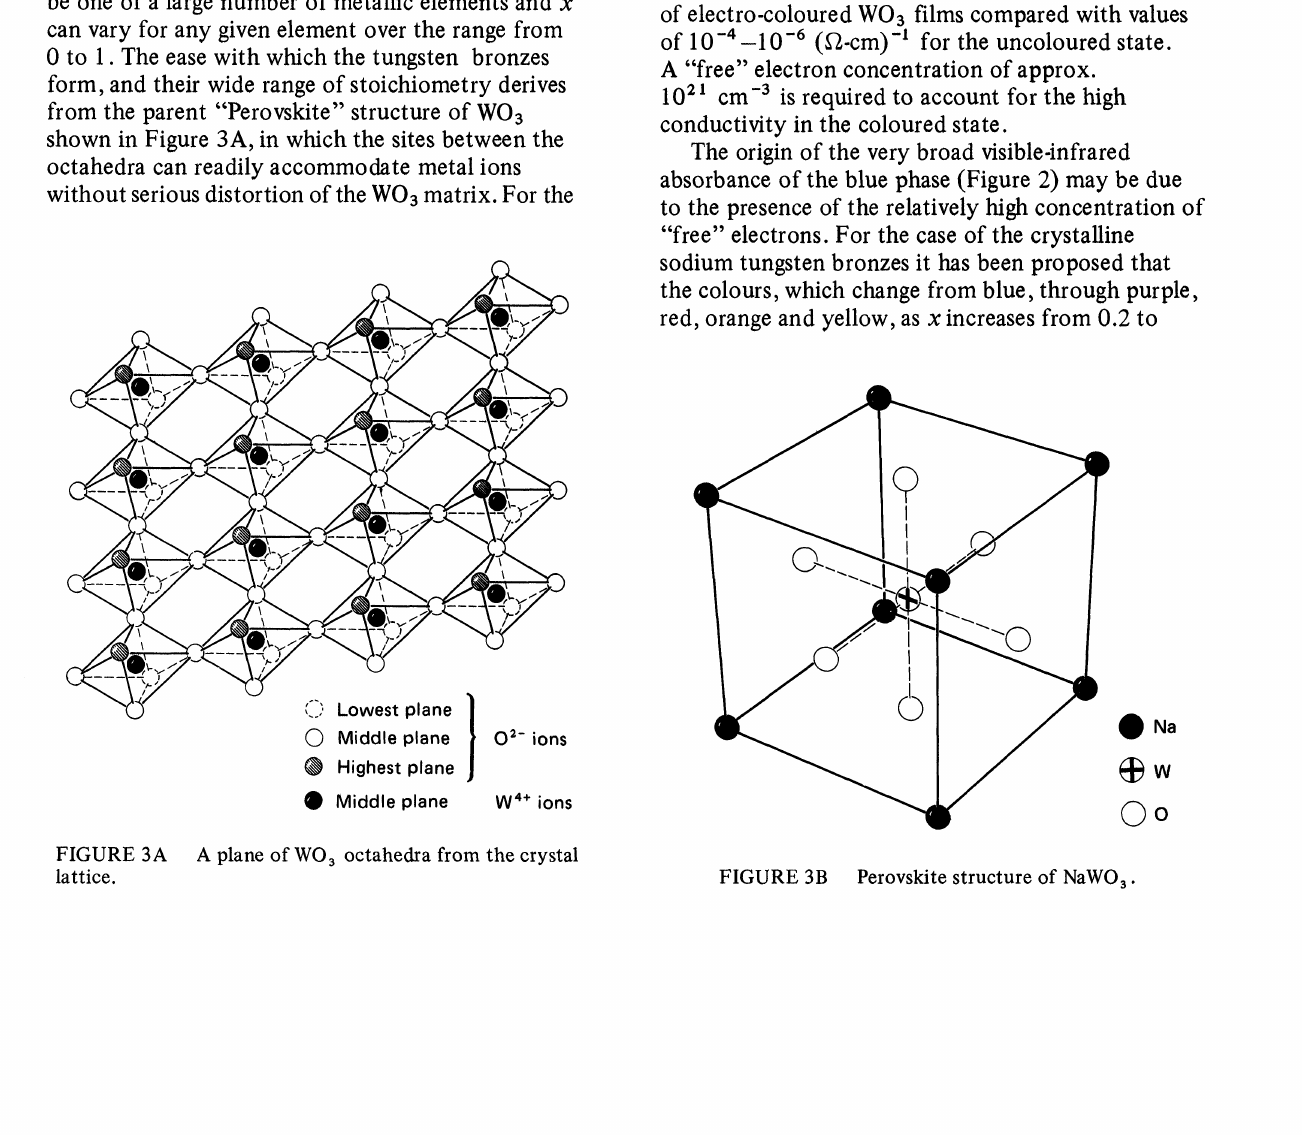
Perovskite structure of